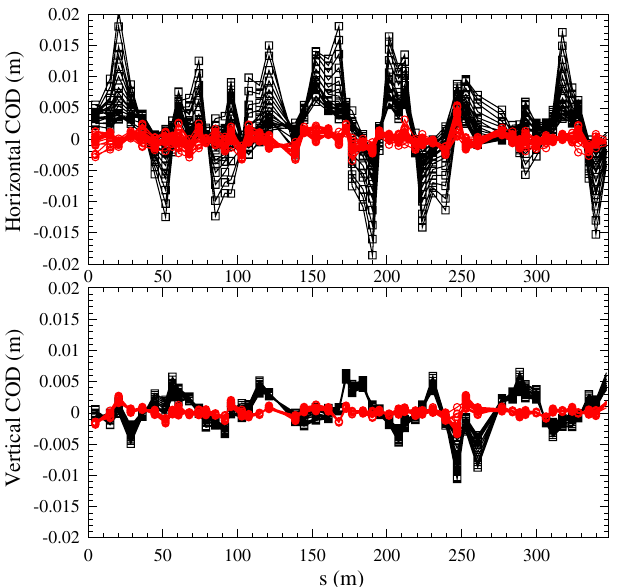
FIG. 19. (Color) Horizontal (upper) and vertical (lower) COD on ring-BPM’s without (black squares) and with (red circles) the COD correction by the steering magnets, where 20 COD’s are plotted for each at 1 ms regular intervals over the acceleration cycle (20